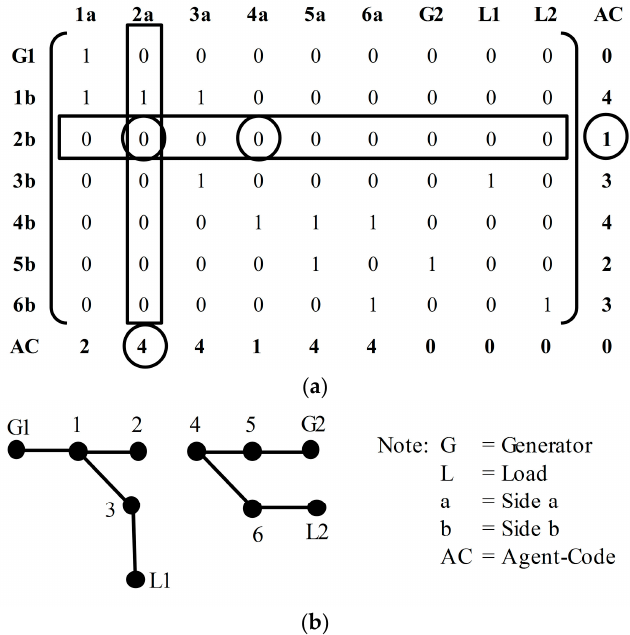
Figure 2. Update TM model for CB2 trip. ( a ) New TM; ( b ) Topology graph.